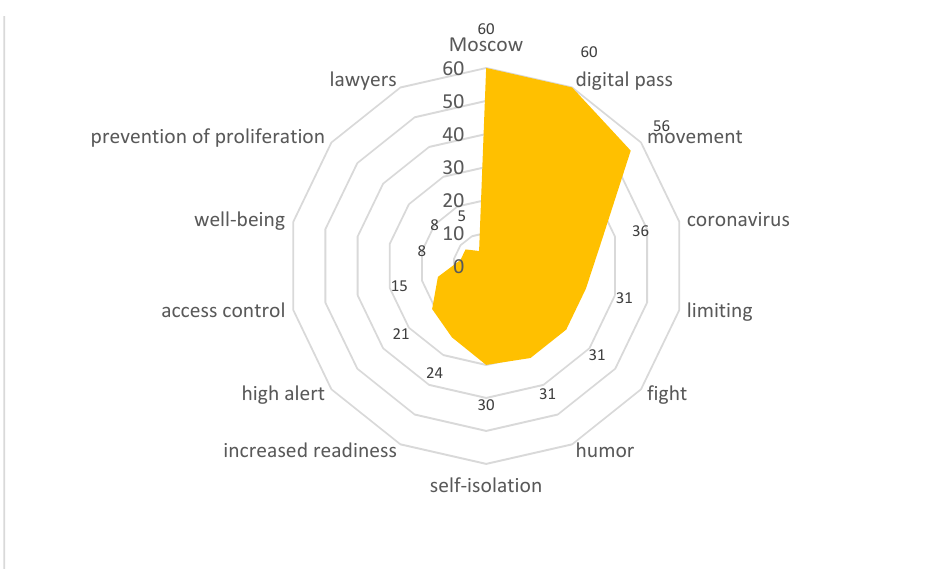
Figure 18. Associative network for stimulus electronic pass.